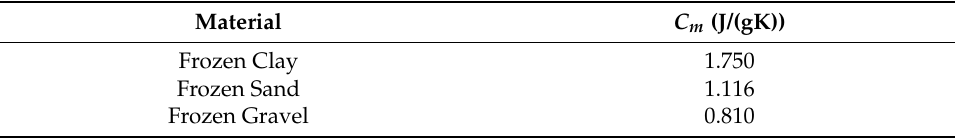
Table 3. Values C m of adopted in this